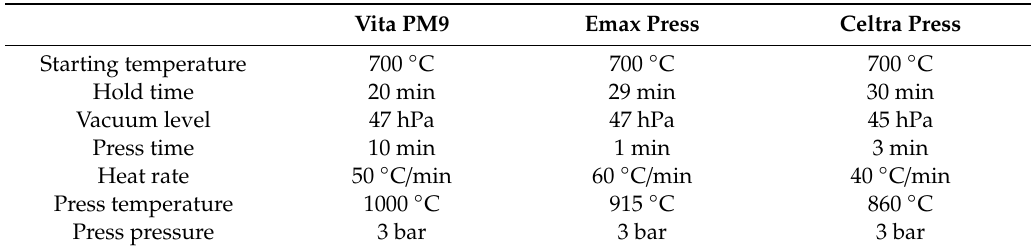
Table 2. Parameters for heat-pressing